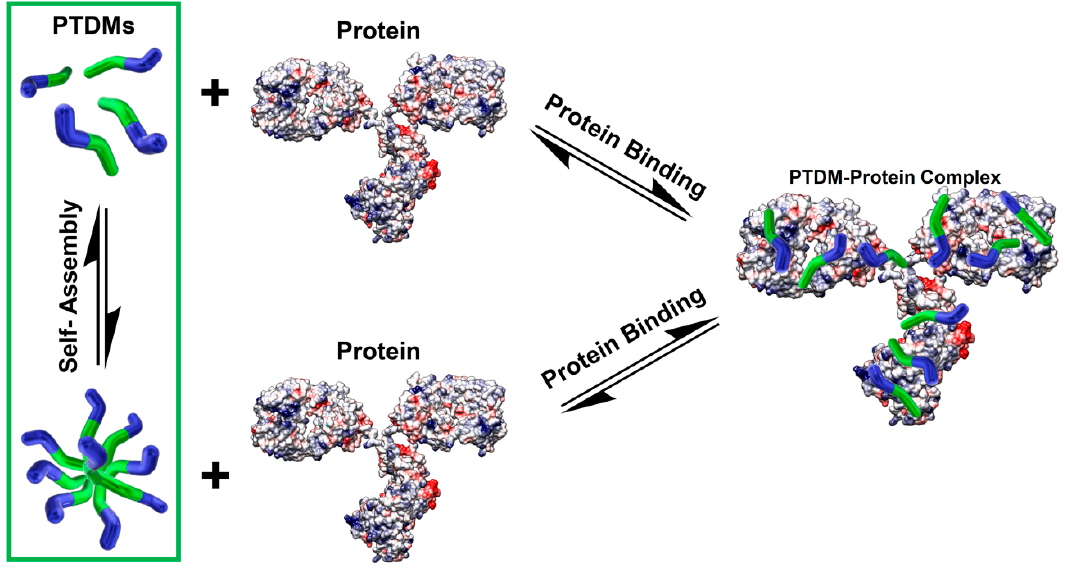
Figure 1. Two hypothesized pathways by which PTDMs could bind protein cargo: one involving single chains in solution and another involving self-assembly. The Coulombic surface potential model of immunoglobulin (Protein Data Bank (PBD) ID: 1IGT), shown without ligands, was generated